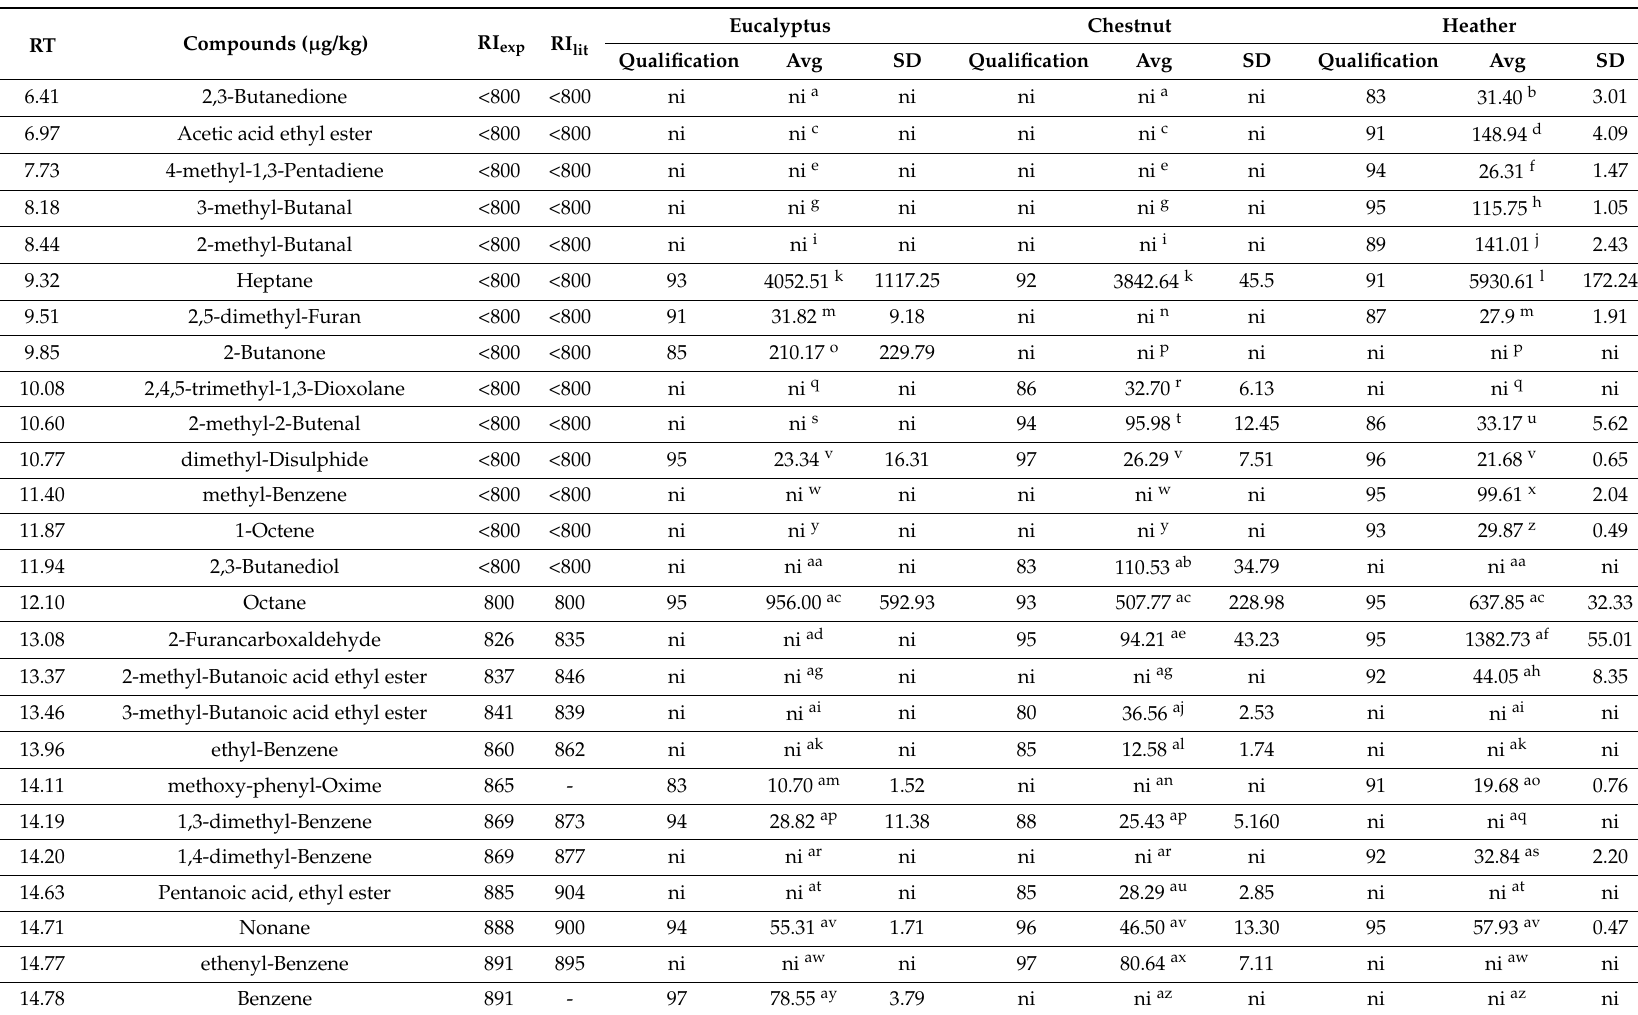
Table 4. Semi-quantitative data ( µ g/kg) of Portuguese honeys according to botanical origin assuming a response factor equal to 1 for all the isolated